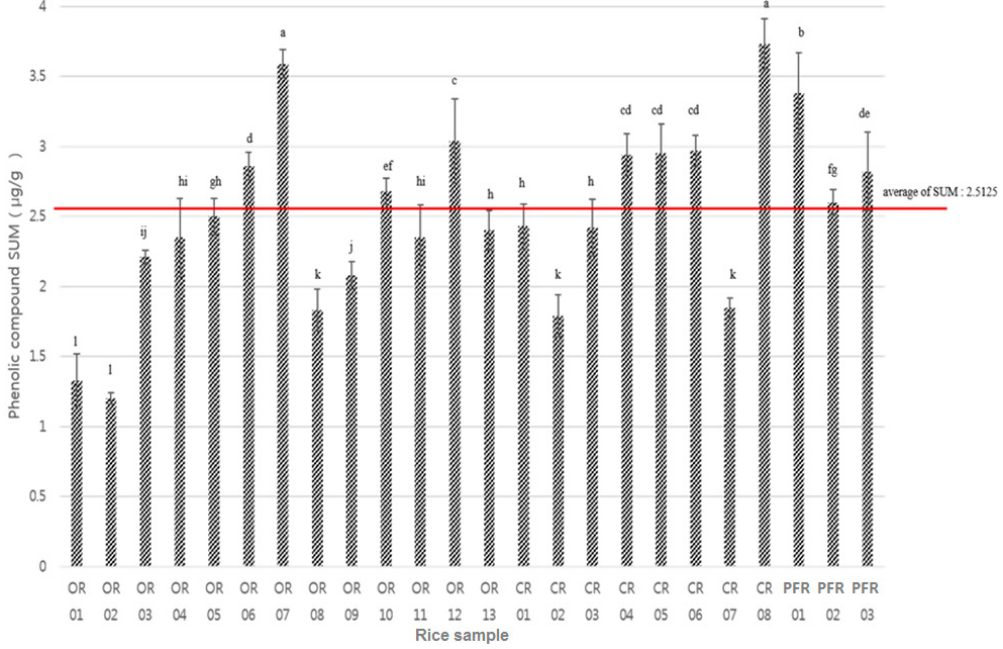
Figure 5. Distribution sum of the phenolic compounds in each sample. Letters a–l indicate a significant difference among the three groups ( p < 0.0001).